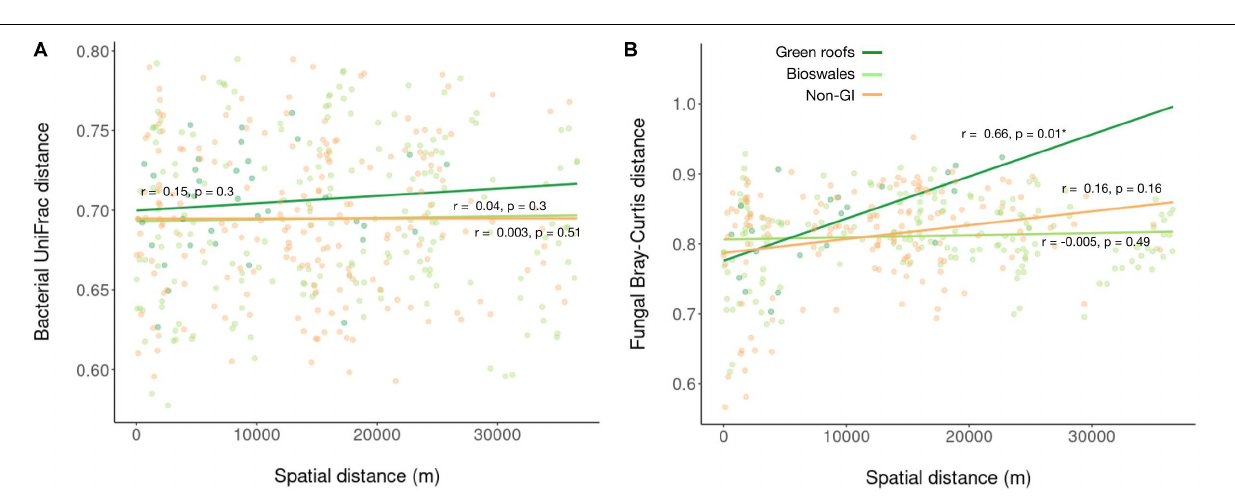
FIGURE 3 | Linear regression of bacterial (A) and fungal (B) pairwise Bray–Curtis distances against pairwise spatial